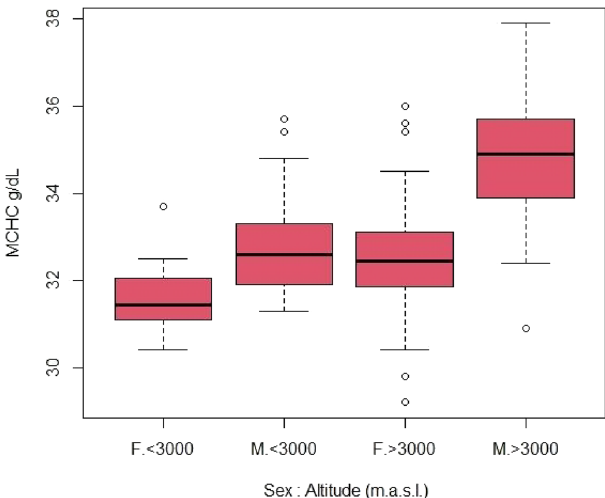
Figure 1. Differences in MCHC by sex and altitude of residence.